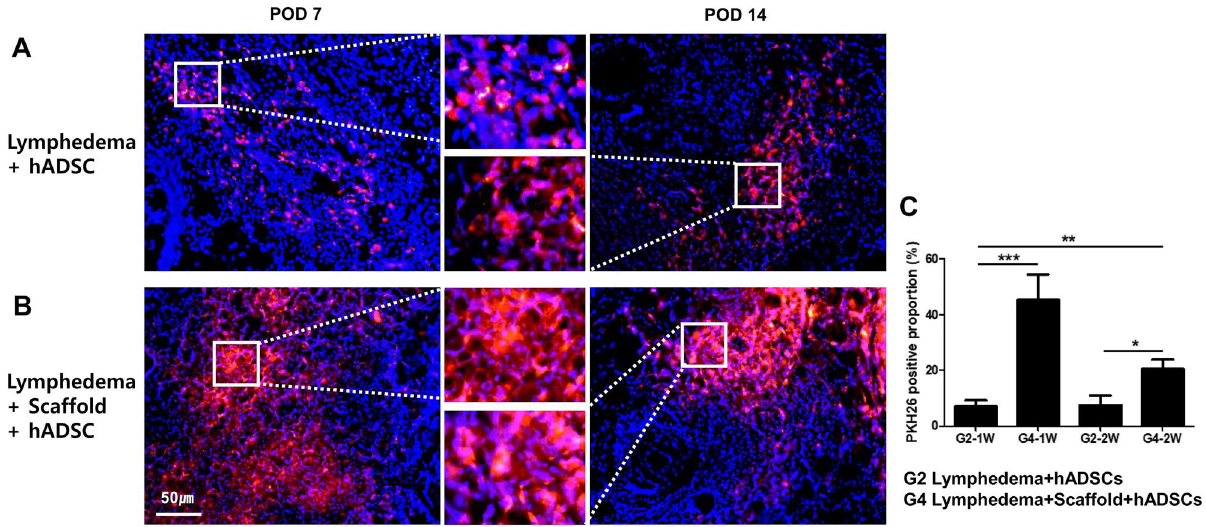
Figure 2. Fluorescent dye-labeled human adipose-derived stem cell (hADSC) tracing. ( A ) PKH26-labeled hADSCs (1 × 10 6 /50 µL) were directly injected into the inguinal lymph nodes site of lymphedema models. ( B ) The lymph node scaffolds were recellularized by PKH26-labeled hADSCs and were transplanted. Large numbers of PKH26-labeled ADSCs were detected in lymph node scaffolds from postoperative day 7 and 14. ( C ) Bar graphs showing that rat in the recellularized LN-scaffold group had the greatest number of PKH26-positive cells (* P < 0.05, ** P < 0.01, *** P <